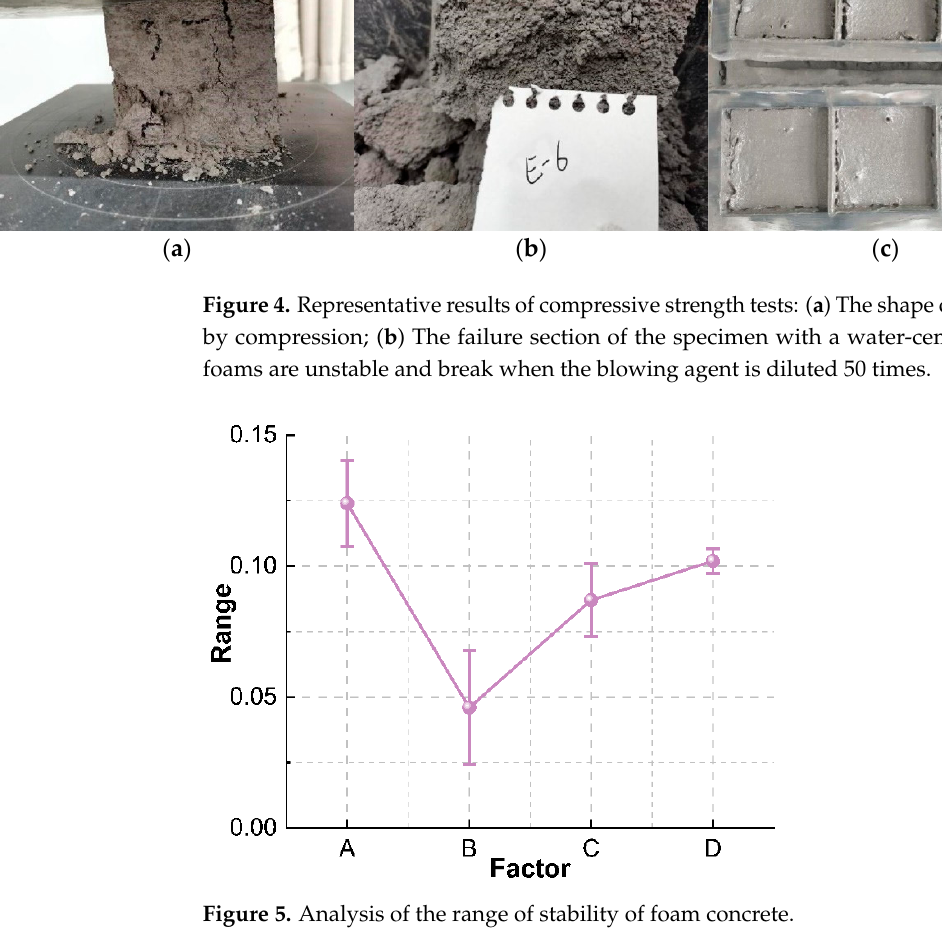
Figure 5. Analysis of the range of stability of foam concrete.